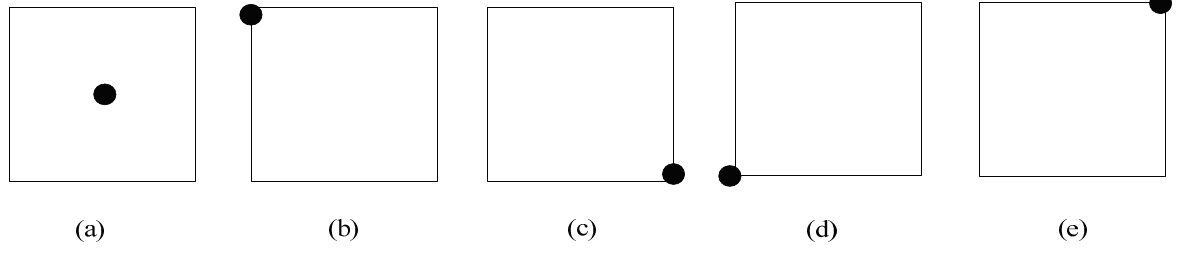
Figure 5. The five buffer zones. ( a ) Center; ( b ) Upper left; ( c ) Bottom right; ( d ) Bottom left; ( e ) Upper